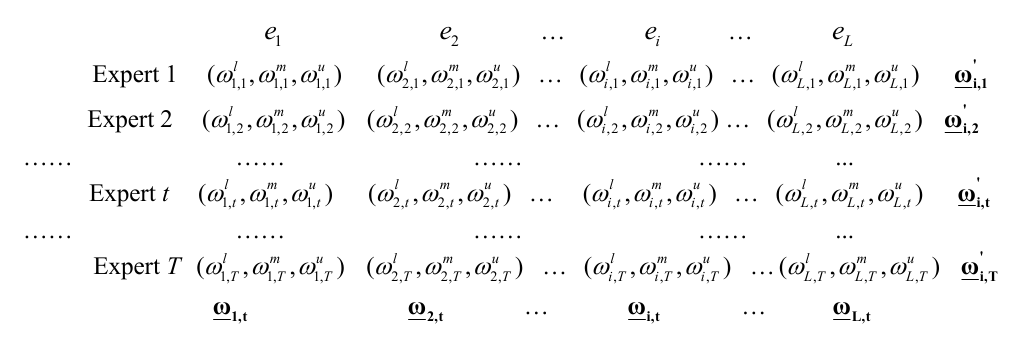
Fig. 2. Triangular fuzzy weights matrix of all L attributes by T experts